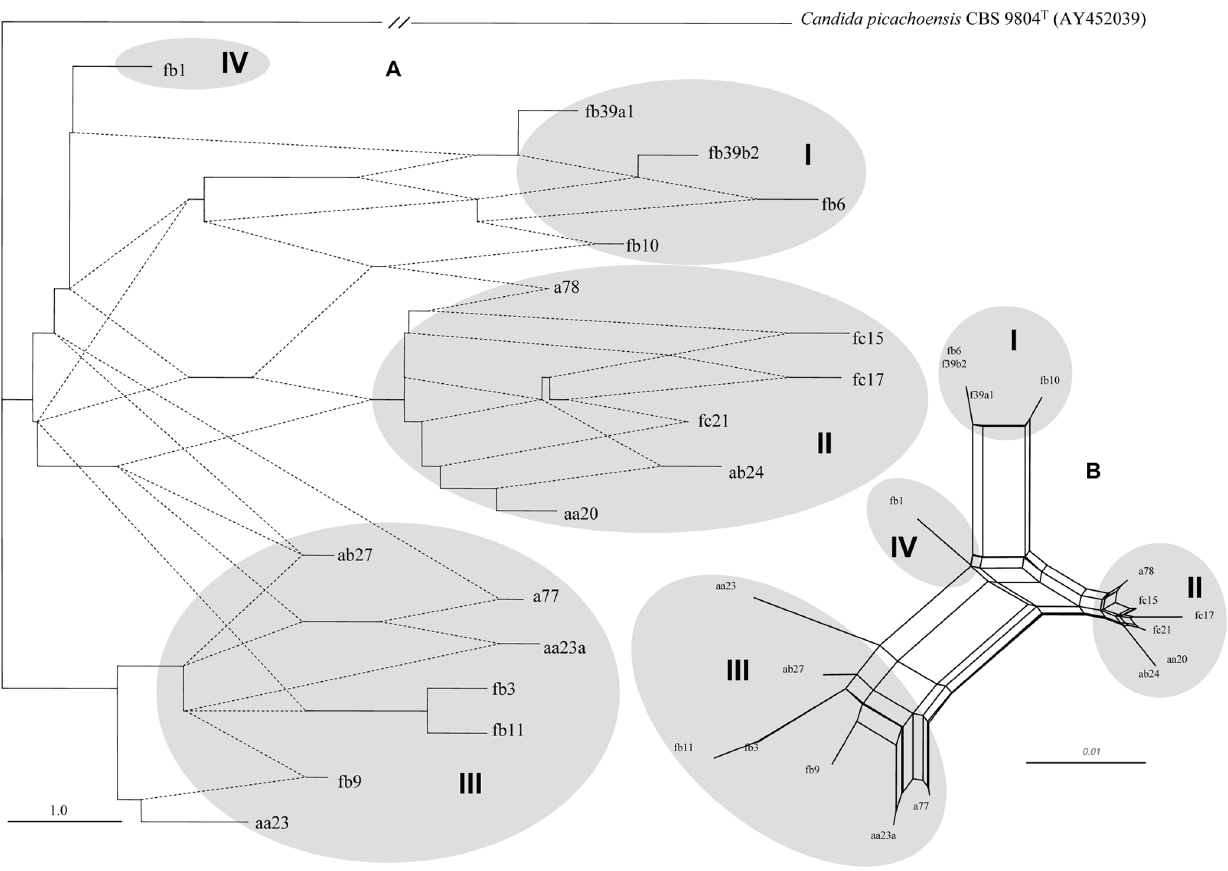
Figure 5. Network analysis of the cloned D1/D2 sequences. (A) Rooted rectangular phylogenetic network. Dotted lines represent network edges. (B) Neighbor-net splits graph. The scale bar represents the split support for the edges. Clusters described in the text are denoted by Roman numerals.